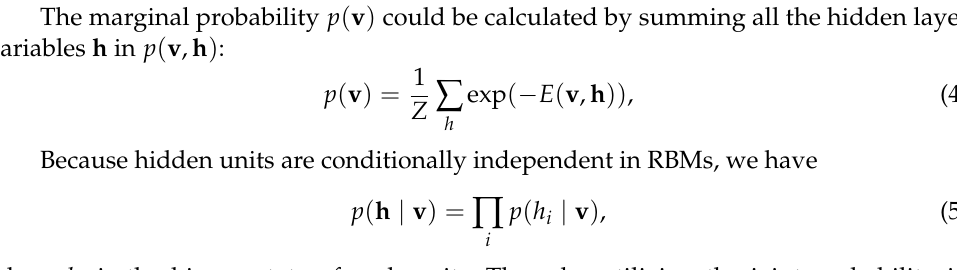
Figure 1. A restricted Boltzmann machine with a binary visible layer and binary hidden